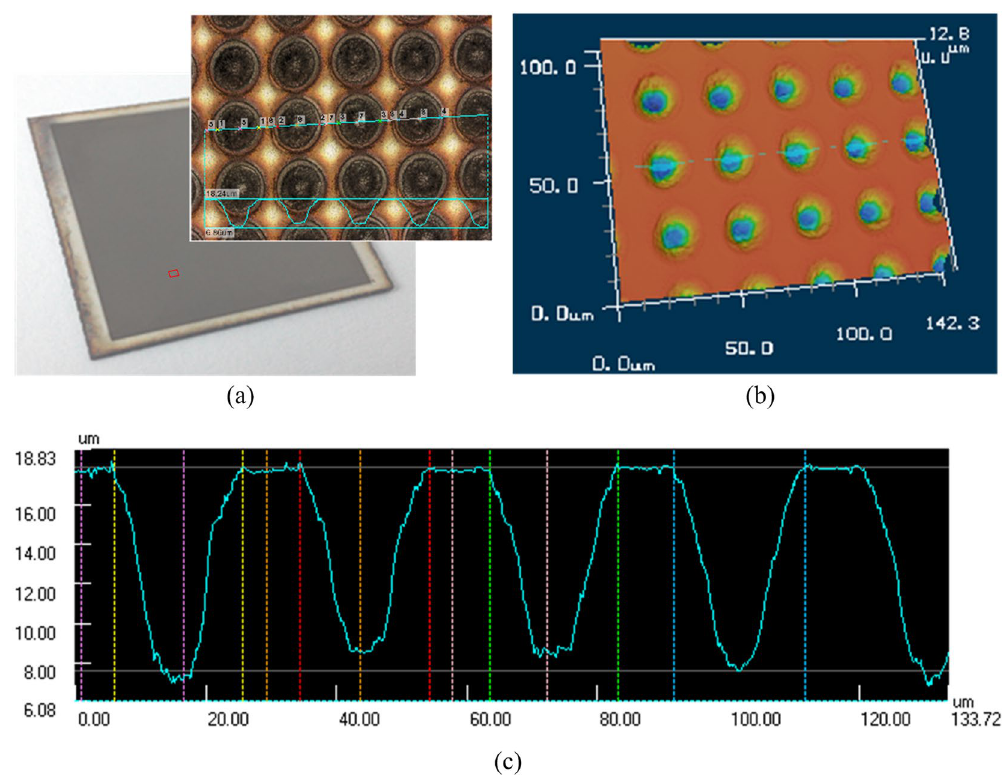
Figure 2. The morphology of the laser ablated surface: ( a ) The optical image and 2D topography map of the scanned area. ( b ) The 3D image of a laser ablated stainless steel foil. ( c ) The cross-section profiles along the radial direction of the